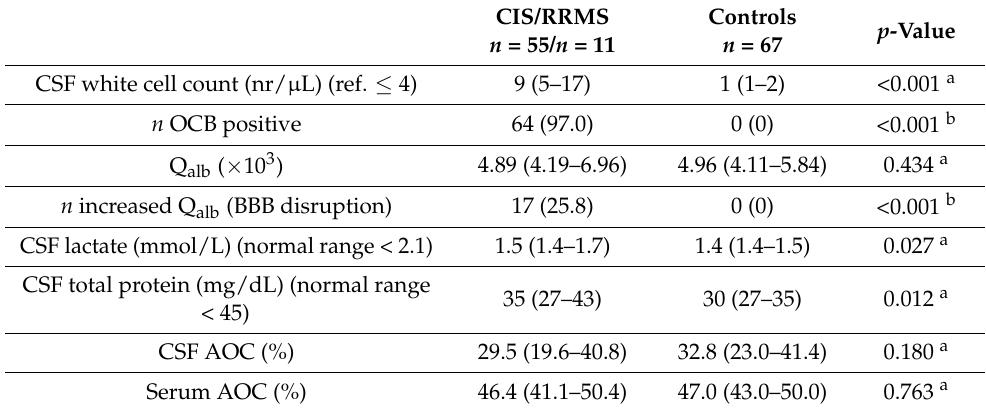
Table 2. Routine diagnostic parameters and AOC in CSF and serum of patients and